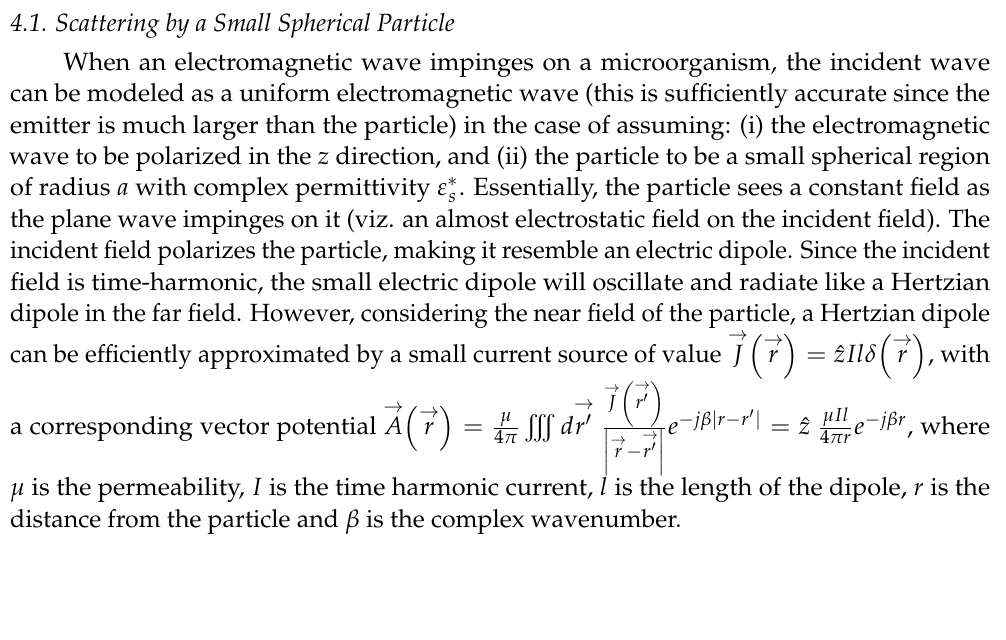
Figure 5. The electromagnetic response of bacteria depends on their shape and size, their internal structure and the complex relative permittivity of the different bacterial cell components, which may depend on the bacterial physiological state. ( a ) Scheme of the configuration and relevant values considered, where ε ∗ r , s stands for complex relative permittivity of the single cell, a radius, ε ∗ r , m complex relative permittivity of the surrounding medium, d p is the length of the illumination and detection plates, and d s is the distance to the cell (considered equally spaced). ( b ) Real relative permittivity, conductivity and thickness/volume of the different parts of bacteria have been extracted from [52,53] and are congruent with [29,34].